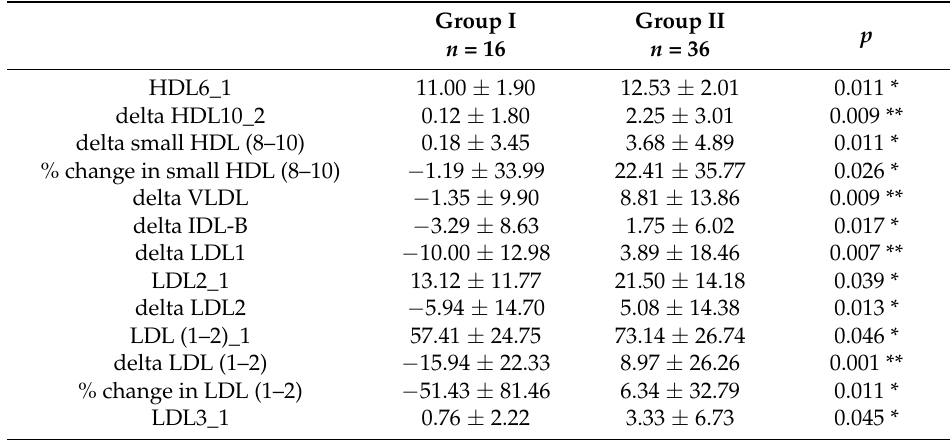
Table 6. Average values of statistically significant HDL-C and LDL-C sub-fractions in study groups, categorized according to the AIP regular formula. Group